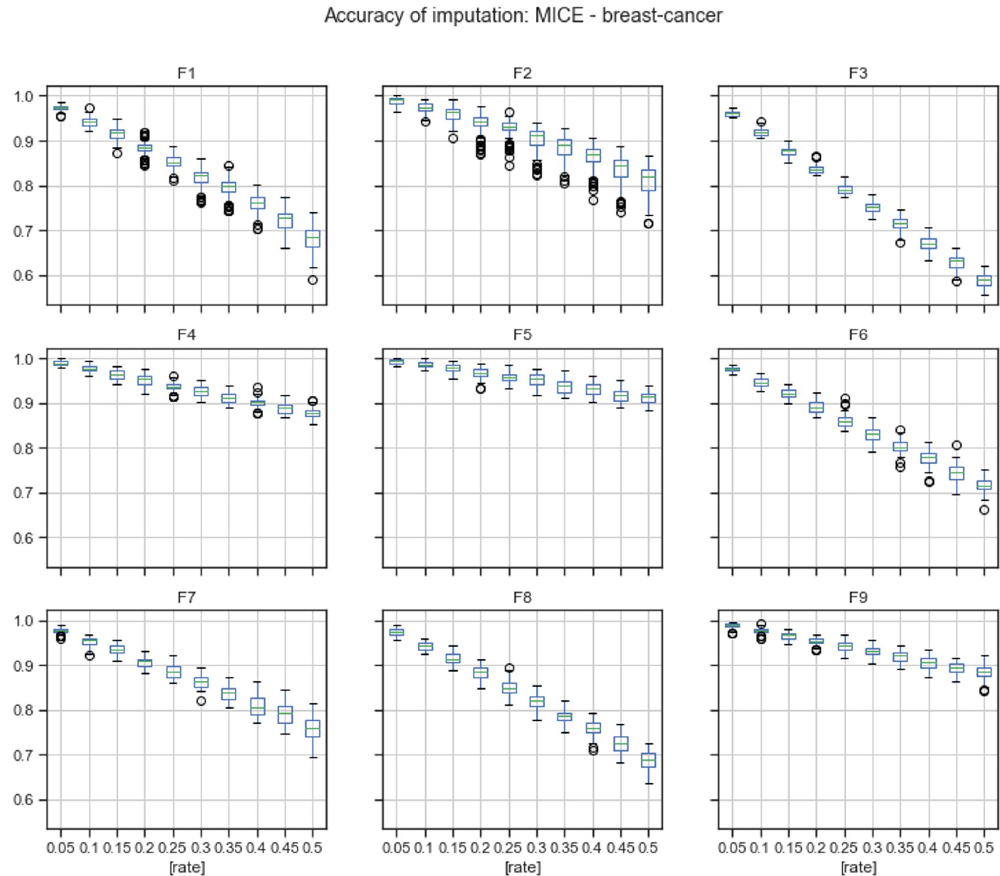
Fig 3. Accuracy of imputations of MICE by